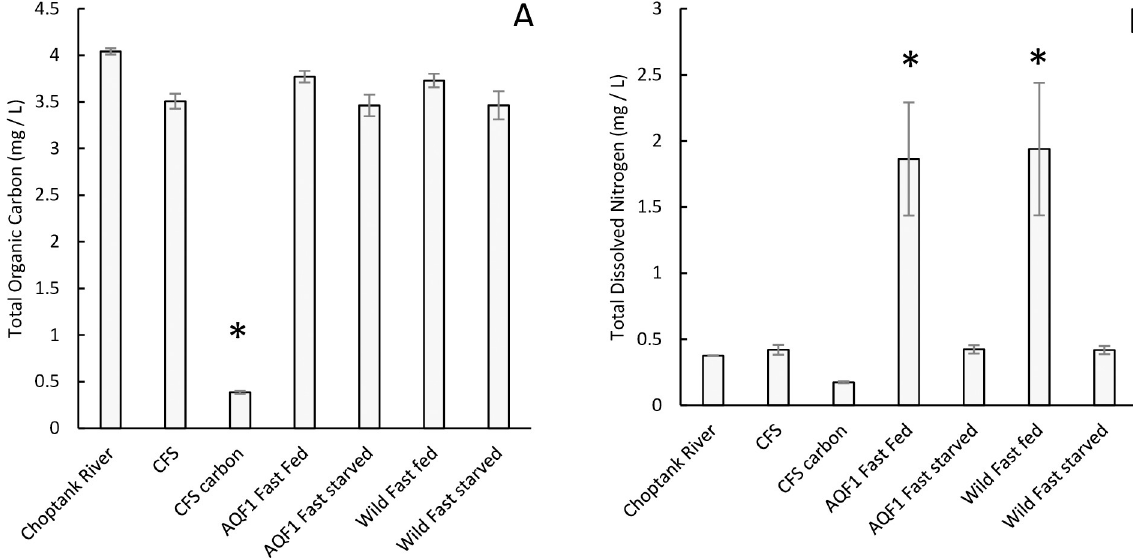
Fig 3. Total organic carbon (A) and total dissolved nitrogen (B) in water collected directly from the Choptank River, the Cartridge Filtration System (CFS) used for experiments, and water from the filtration system with an additional carbon filter (CFS carbon). Additionally, water samples were collected from fed and starved treatments during water changes for comparison. Samples from the buckets were taken after approximately 24 hours of larval culture. Asterisks indicated water samples that are significantly different.